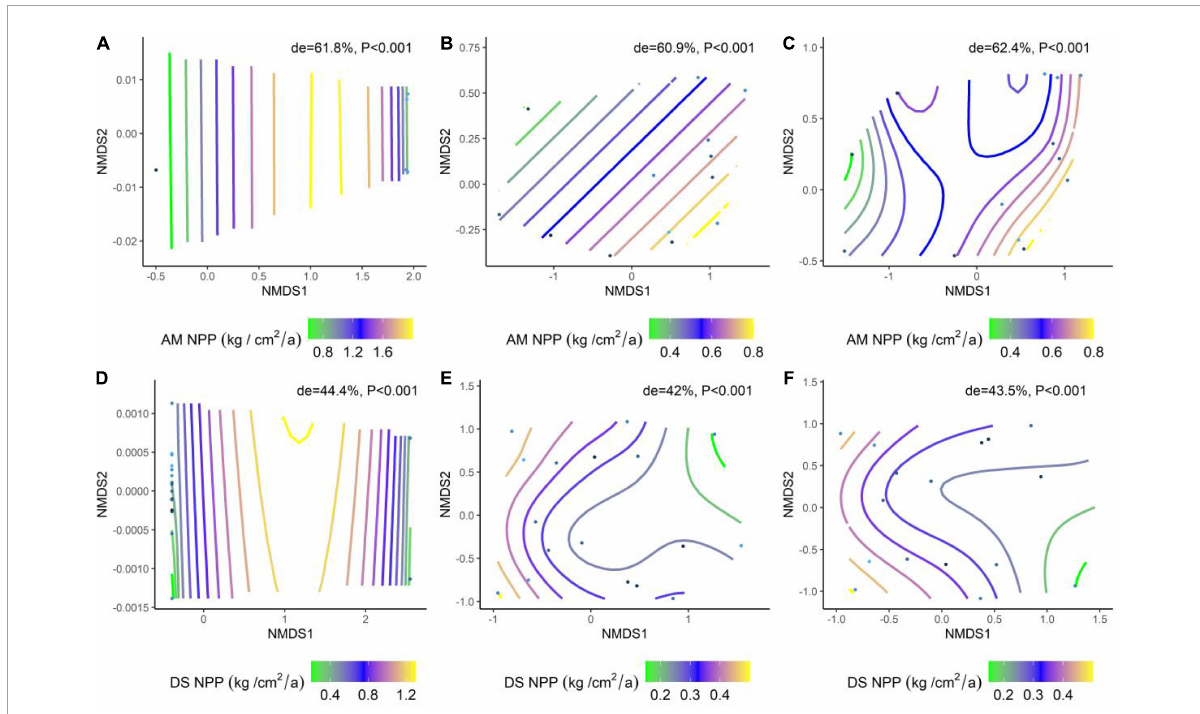
FIGURE5 The results of the generalized additive model (GAM) fitted the effects of environmental factors and climate factors on grassland NPP. (A) NMDS ranking of soil factors and the NPP of AM; (B) NMDS ranking of climate factors and the NPP of AM; (C) NMDS ranking of environmental factors and the NPP of AM; (D) NMDS ranking of soil factors and the NPP of DS; (E) NMDS ranking of climate factors and the NPP of DS; (F) NMDS ranking of environmental factors with the NPP of DS. The color spline shows the fit of trait data from high (green) to low (yellow) values during the ranking. Trait overlays indicate that abiotic factors represented by points on the NMD are associated with higher or lower trait values, consistent with the colored trait gradient. Note that if the relationship between NPP and abiotic factors is linear, the gradient spline lines will be parallel. non-linear relationships between NPP and abiotic factors are represented by curve splines; de indicates the deviation explained by the corresponding